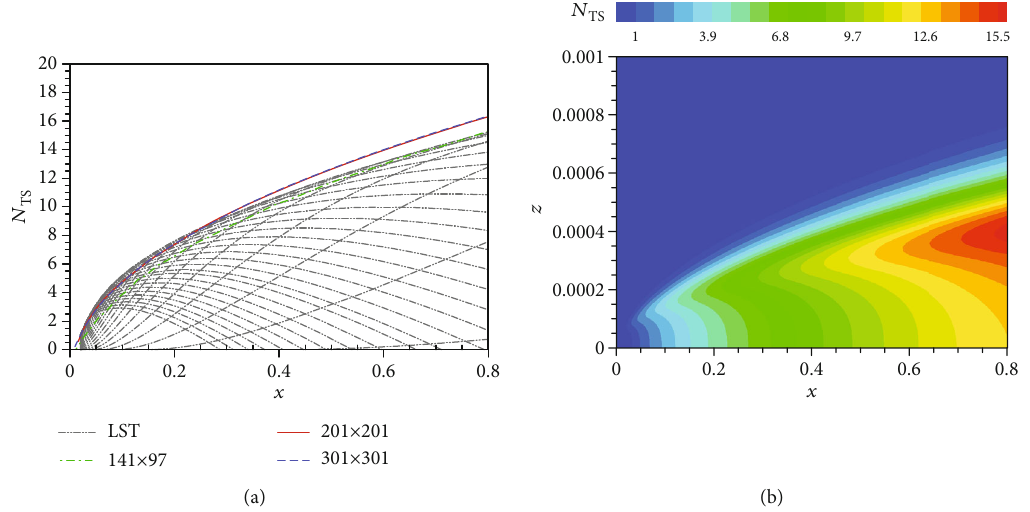
Figure 3: Predicted results of ampli fi cation factor. (a) Comparison with standard LST analysis results. (b) Contour at Mach number = 2 : 2 and Reynolds number = 5 : 6 × 10 7 /m